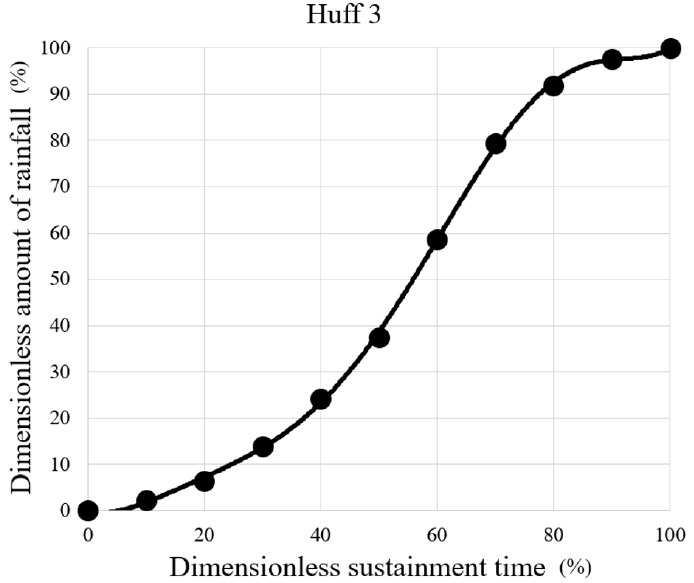
Figure 7. Huff third quartile distribution curve for Busan area.